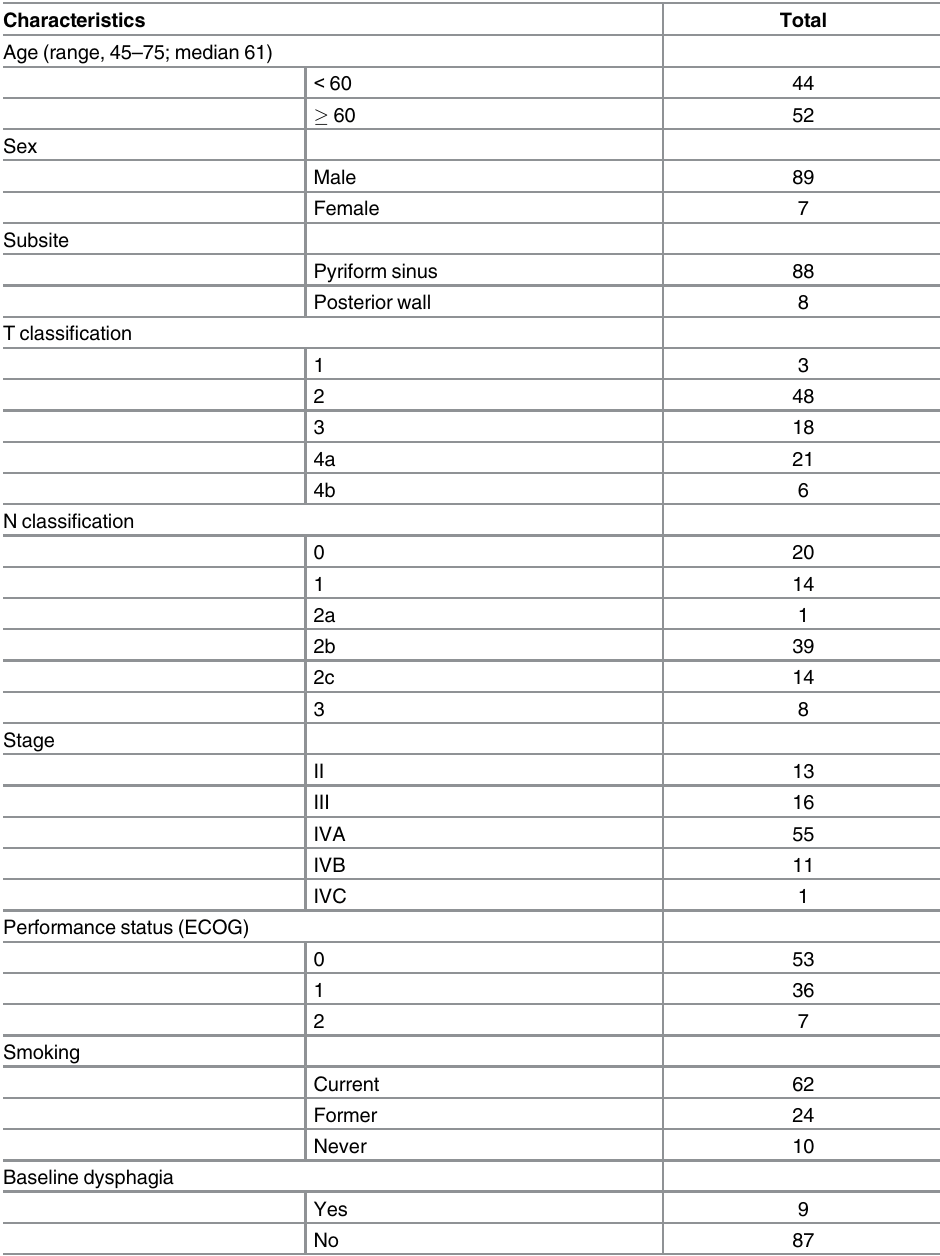
Table 1. Patient characteristics. Swallowing outcomes Nine patients were G-tube use at baseline. Table 3 details swallowing outcomes at 1, 3, 6, 12, 24 months after CCRT. One patient could not receive oral intake due to pharyngeal stricture after IV-CCRT and subsequently underwent total laryngo-pharyngectomy and reconstruction by